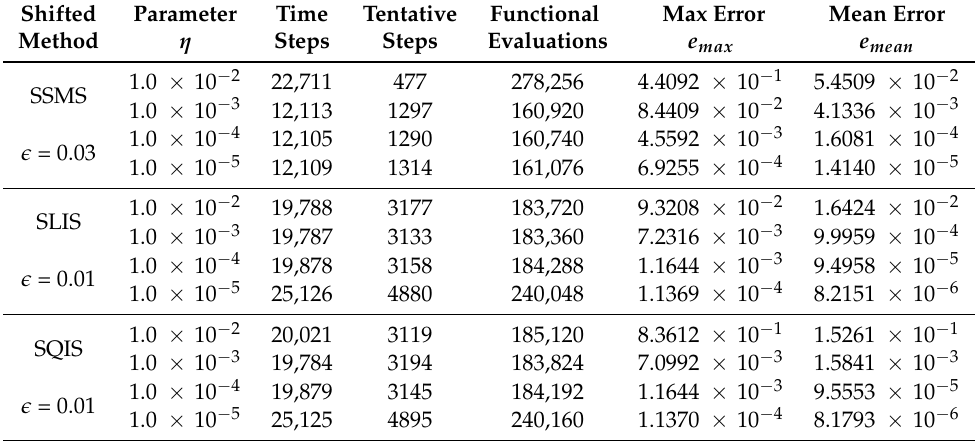
Table 13. Results of the shifted Strang–Marchuk’s splitting (SSMS) the shifted linear iterative splitting (SLIS), and the shifted quasilinear iterative splitting (SQIS), for the uphill case of the NLD equation. Shifted